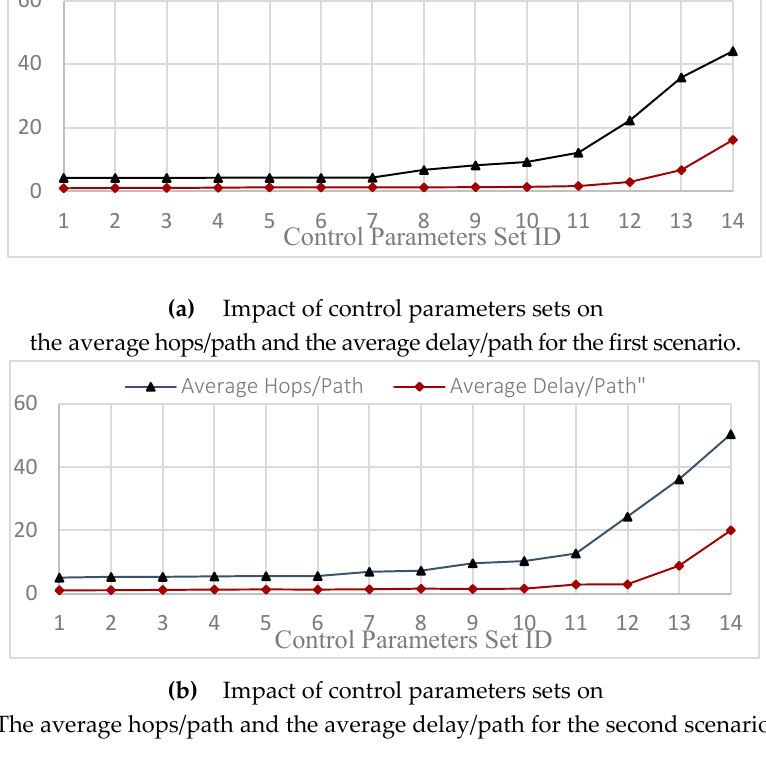
Figure 5. Impact of control parameters sets on the average hops/path and the average delay/path.